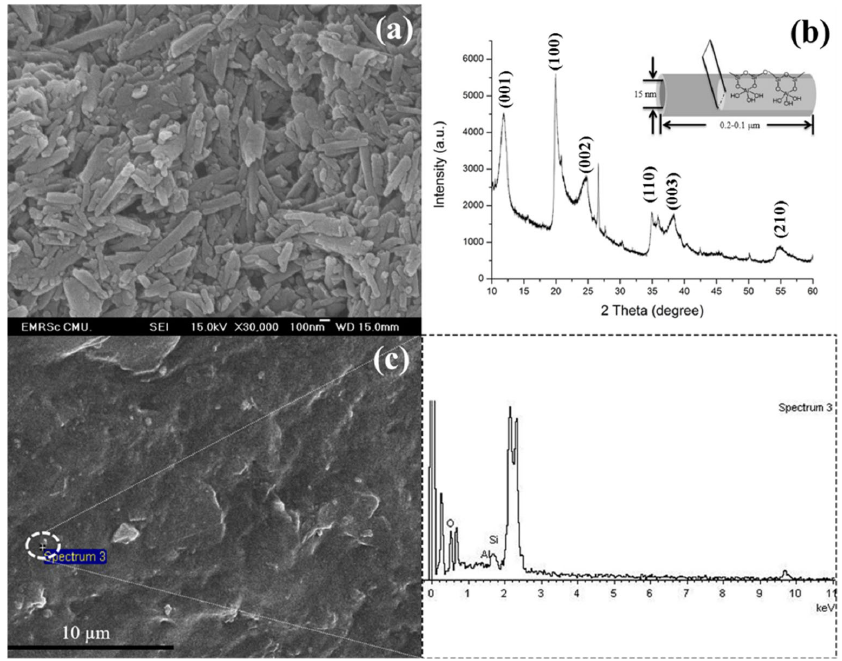
Figure 2. FE  SEM image of ( a ) As  supplied HNT, ( b ) XRD pattern and crystalline structure of HNT Figure 2. FE − SEM image of ( a ) As − supplied HNT, ( b ) XRD pattern and crystalline structure of HNT and ( c ) SEM image and EDS spectrum of HNT in SPE. and ( c ) SEM image and EDS spectrum of HNT in SPE.